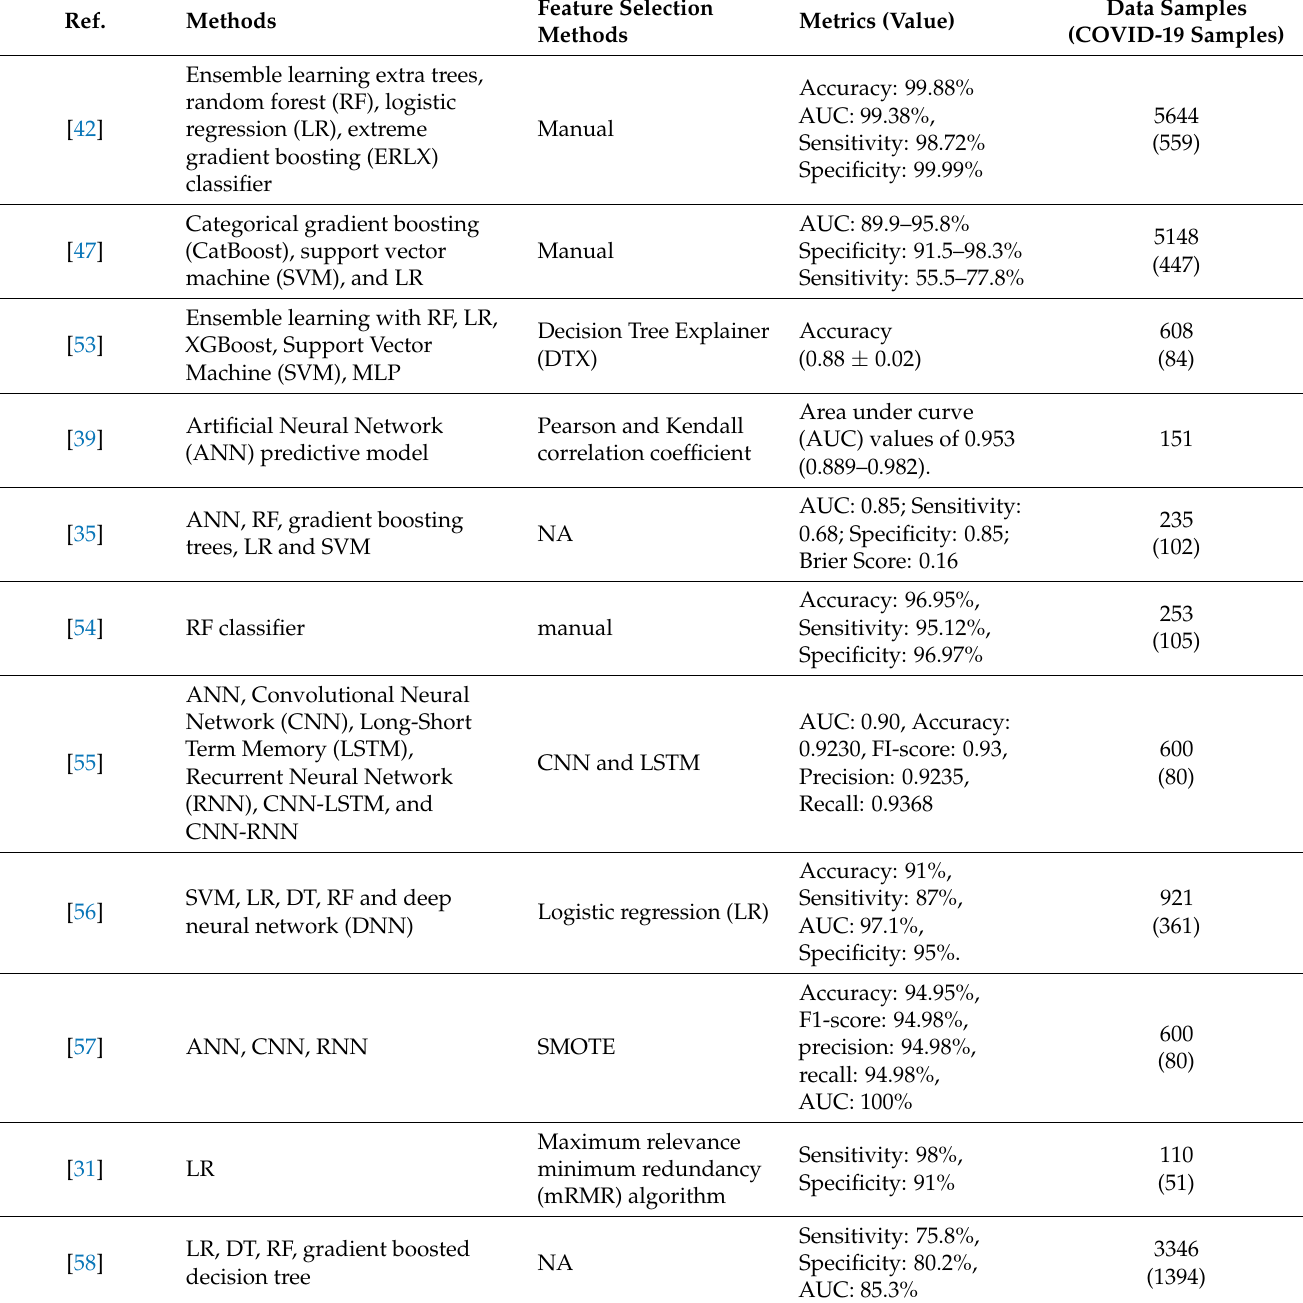
Table 1. Summary of related work on COVID-19 identification from blood